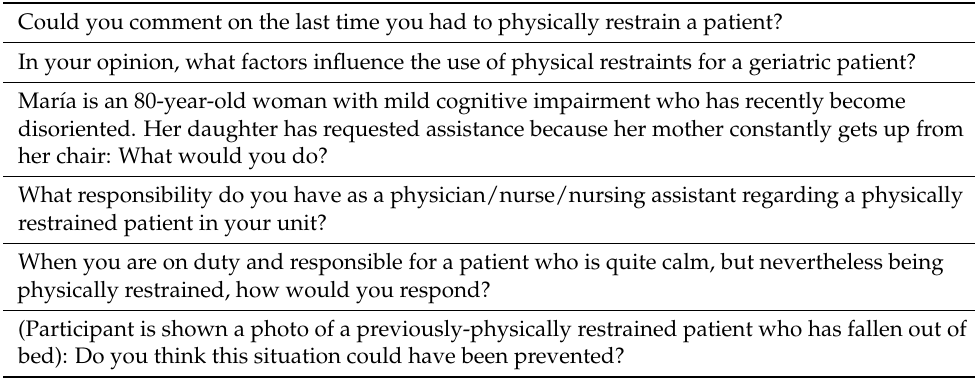
Table 3. Script for the interview with (non-management) healthcare